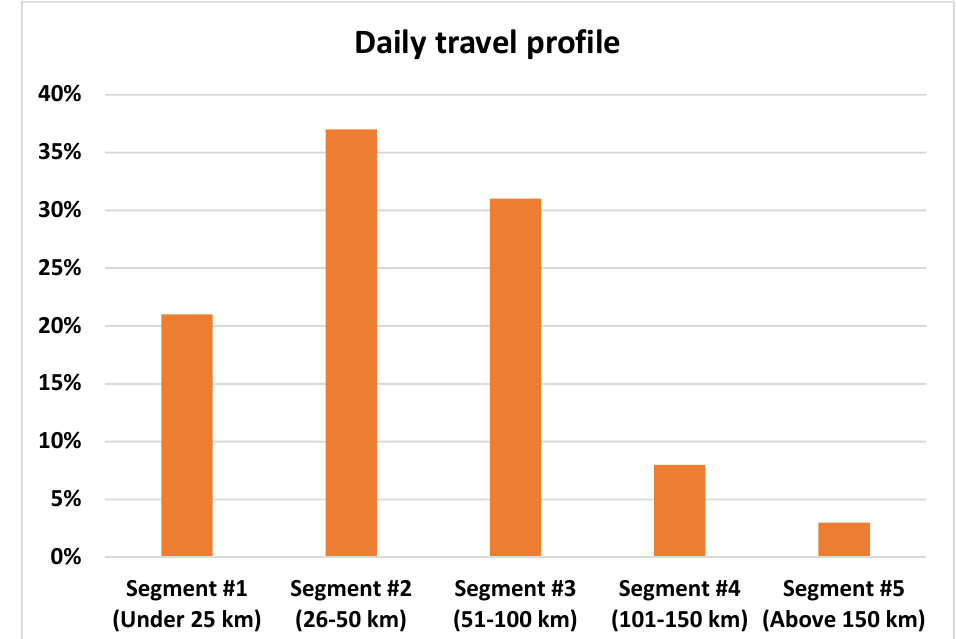
Figure 2. Daily mileage of participants.